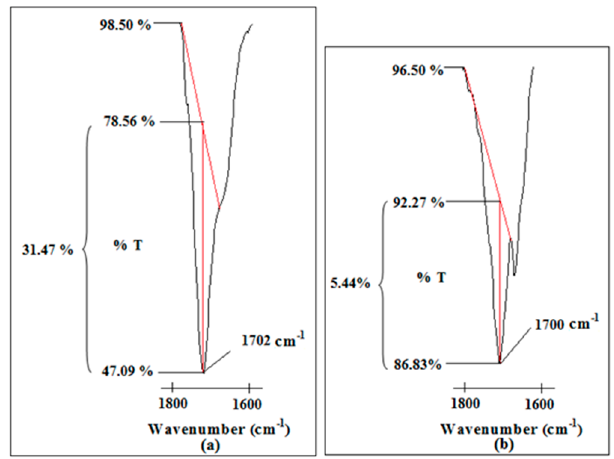
Figure 9. The change in peak intensity of C=O stretching mode of carboxylic group of PAA in ( a ) Ti 0 and ( b ) Ti 3.